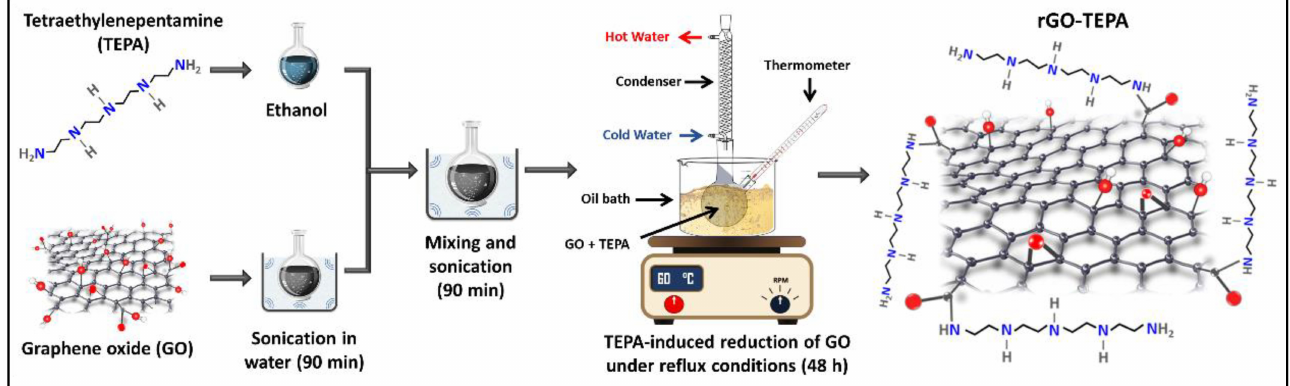
Figure 1. Schematic representation of the TEPA-induced GO reduction and the predicted chemical structure of